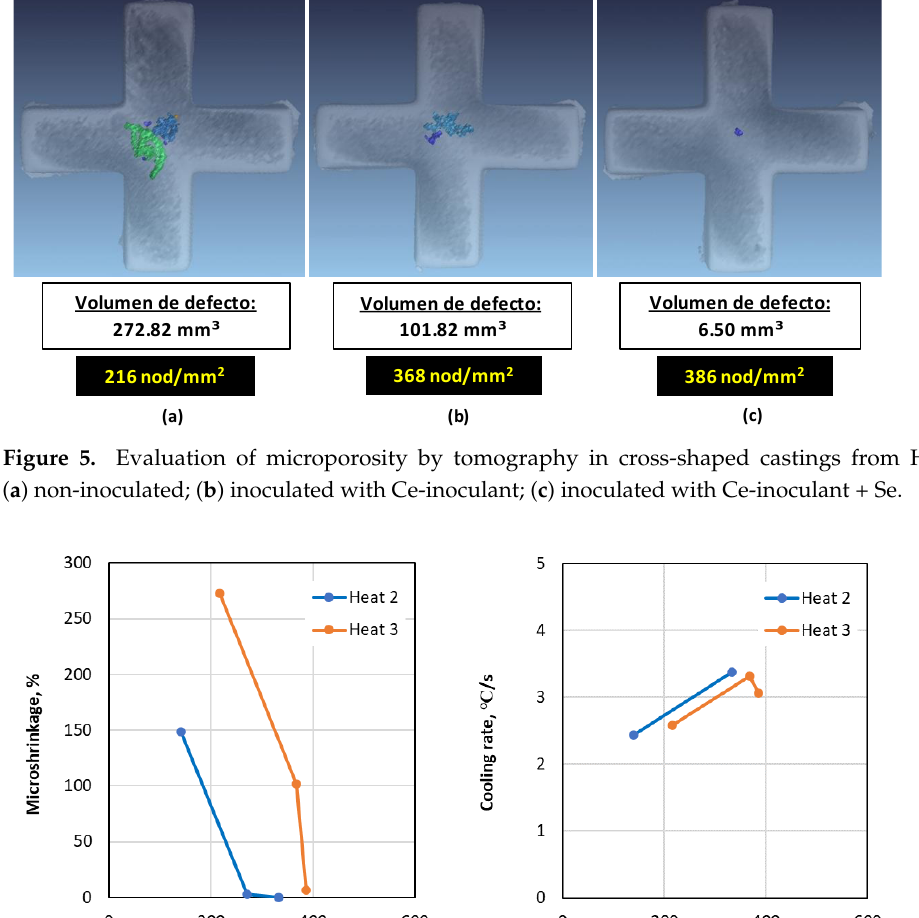
Figure 5. Evaluation of microporosity by tomography in cross-shaped castings from Heat 3: ( a ) non- inoculated; ( b ) inoculated with Ce-inoculant; ( c ) inoculated with Ce-inoculant + Se.